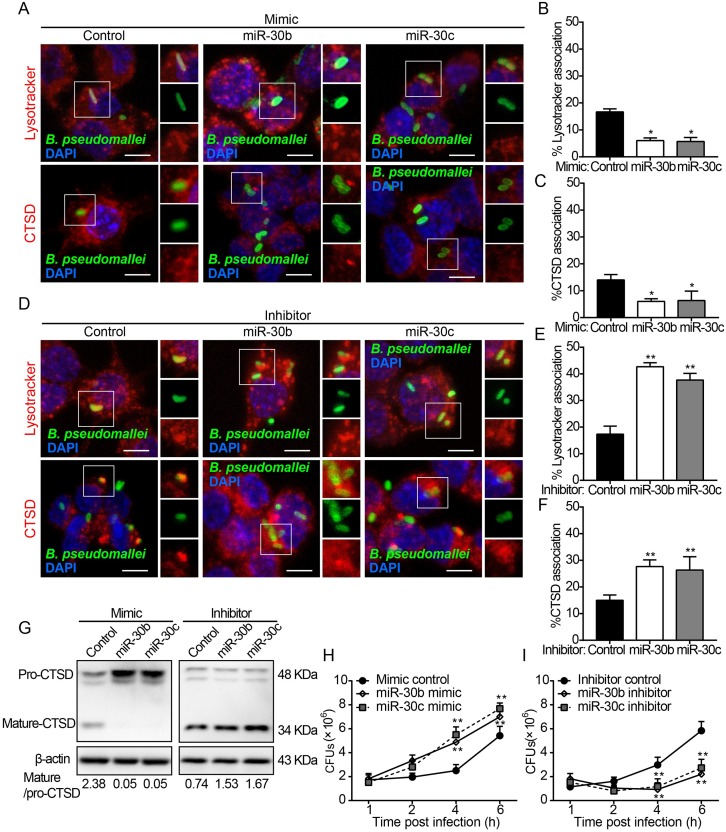
MiR-30b and miR-30c affect phagosome maturation and modulate B. pseudomallei intracellular survival in macrophages.(A) BMDMs transfected with control, miR-30b mimic, and miR-30c mimic were incubated with 50 nM Lysotracker (red) for 1 h before infection with B. pseudomallei for 2 h and fixed, stained with an anti-CTSD (red) or anti-B. pseudomallei (green). Scale bar is 5 μm. (B and C) Percent of B. pseudomallei phagosomes that colocalized with Lysotracker and CTSD at 2 h post-infection as in A. Results represented are of three independent experiments. (D) BMDMs were transfected by control, miR-30b inhibitor or miR-30c inhibitor for 24 h, followed by B. pseudomallei infection for 2 h, and were labeled with Lysotracker (red) or stained with an anti-CTSD (red). Scale bar is 5 μm. (E and F) Quantification showing the percentage of association of the bacteria phagosomes with Lysotracker and CTSD as in D. (G) BMDMs were transfected with control, miR-30b mimic, miR-30c mimic, miR-30b inhibitor, and miR-30c inhibitor for 24 h and then infected with B. pseudomallei. The expression of CTSD was determined by Western blot analysis. (H) BMDMs were transfected with control, miR-30b mimic, and miR-30c mimic at 100 nM for 24 h, and were then infected with B. pseudomallei for different periods of time (0, 1, 2, 4, and 6 h). Intracellular bacterial counts were determined. (I) After BMDMs were transfected with control, miR-30b inhibitor or miR-30c inhibitor for 24 h, intracellular survival of B. pseudomallei was detected as in H. Data are representative of at least three independent experiments (*P<0.05, **P<0.01).